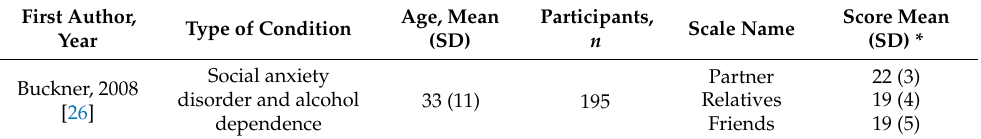
Table 7. Social functioning I–Perceived social support.